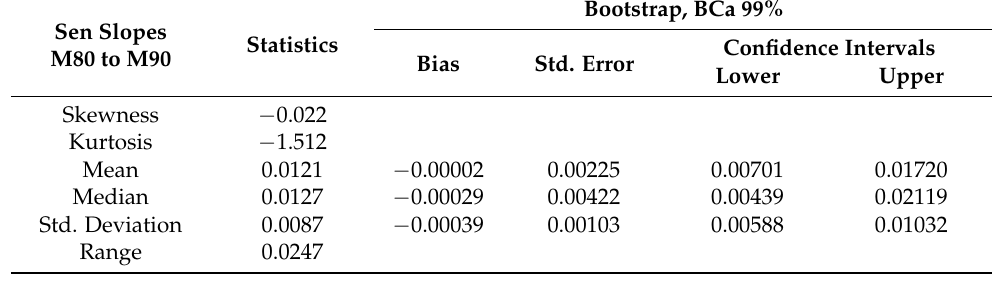
Table 13. Inferential statistics of Sen Slopes for inter decadal runo ff di ff erence between M70 and Table 11. Inferential statistics of Sen Slopes for inter decadal runoff difference between M80 and M90. M90. Sen Slopes